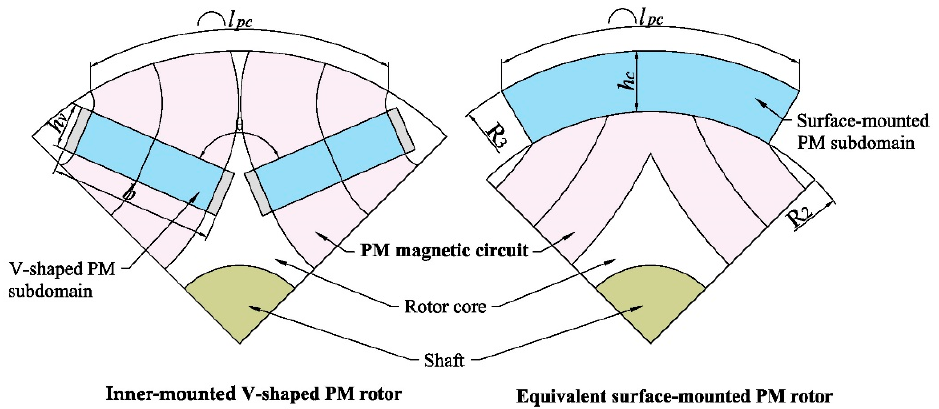
Figure 1. The equivalent model of the PM subdomain.